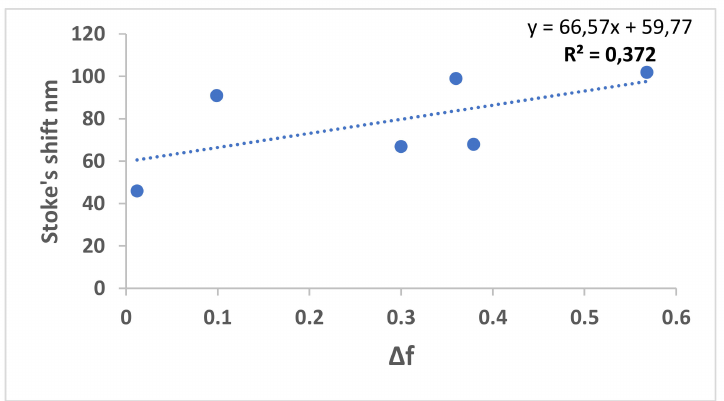
Figure 15. Effect of solvent relative polarity on Stokes shift (nm) of 7.6 × 10 − 5 M of 2-amino-4- hydroxy-6-(4-hydroxy-2-oxo-2H-chromen-3-yl)nicotinonitrile 4